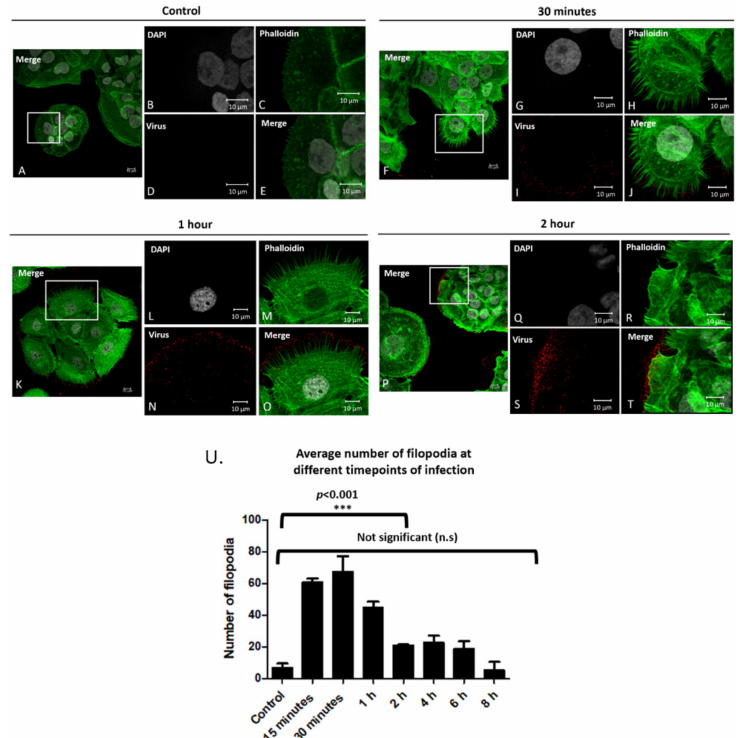
Figure 1. Filopodia numbers increase after the addition of PsVs. Confocal microscopy images of control cells without PsVs addition ( A – E ), and after PsV addition for 30 min ( F – J ), 1 h ( K – O ), and 2 h ( P – T ). Cell nuclei were stained with DAPI (grey), phalloidin stained filopodia (green), and H16.V5 antibody stained HPV16 L1 protein (red). Full merged images of all channels ( A , F , K , P ). Zoomed in images of merged images ( E , J , O , T ). Average number of filopodia per cell after viral addition for 15 min–8 h ( U ). Filopodia were counted using LAS X Life Science Microscope Software Platform for fifteen cells at each timepoint for three separate experiments ( n = 45). Images are shown in X, Y, Z planed Z stacks. An ANOVA Dunnett’s multiple comparisons test was used to evaluate statistical significance (samples were compared to control cells, ***, p < 0.001). Averages are displayed with